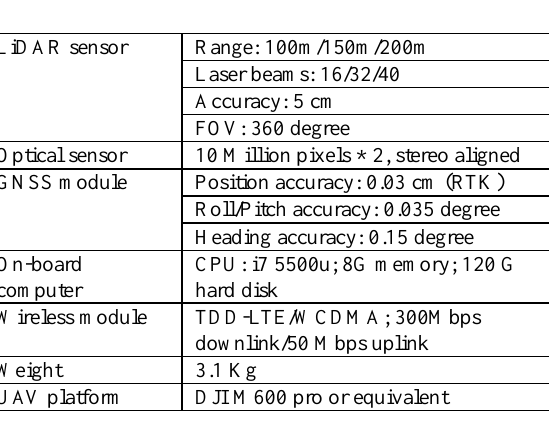
Table 1. Tovos DroneScan technical